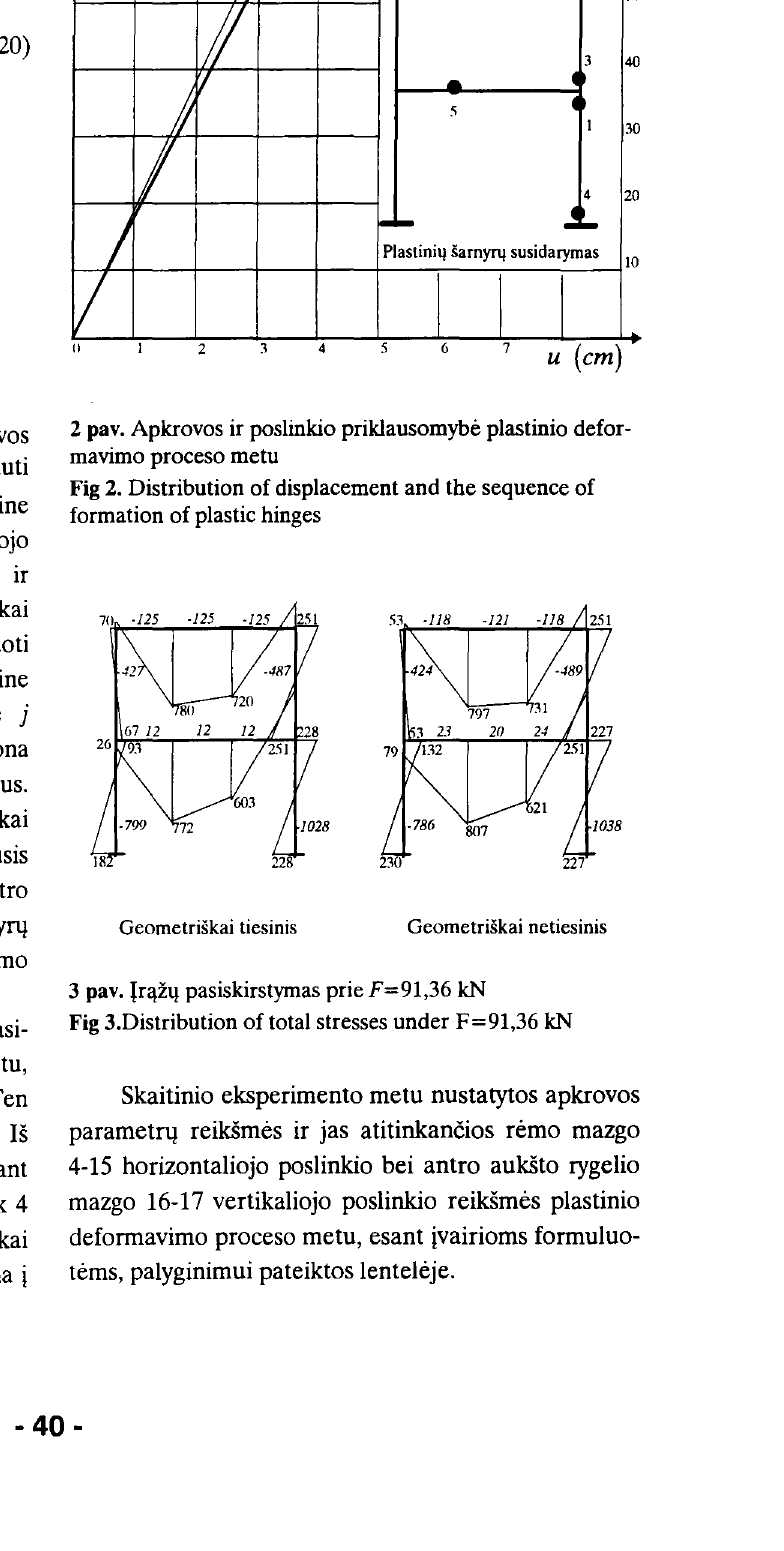
Fig 3.Distribution of total stresses under F = 91,36 kN Skaitinio eksperimento metu nustatytos apkrovos parametrq reikSmes ir jas atitinkancios remo mazgo 4-15 horizontaliojo poslinkio bei antra aukSto rygelio mazgo 16-17 vertikaliojo poslinkio reikSmes plastinio deformavimo proceso metu, esant jvairioms formuluo tems, palyginimui pateiktos